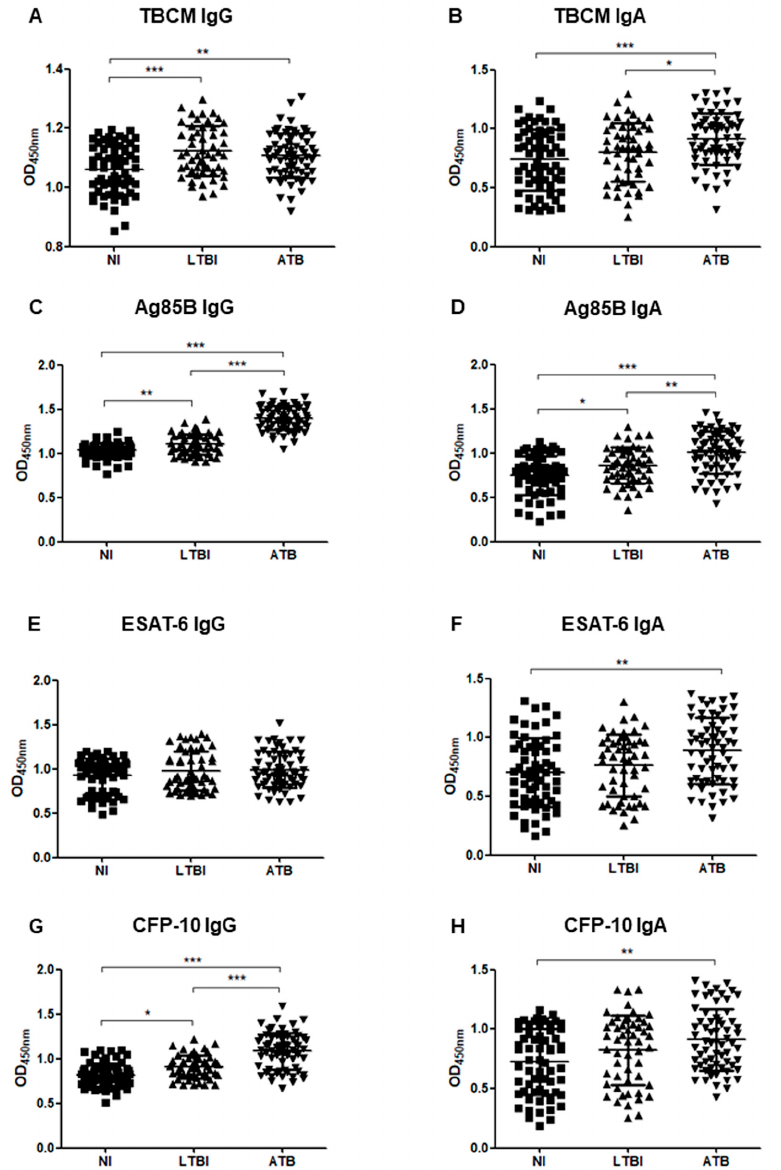
Figure 1. The optical density (OD) values of the anti-TBCM ( Mycobacterium tuberculosis chorismate mutase) immunoglobulin G (IgG) ( A ), anti-TBCM immunoglobulin A (IgA) ( B ), anti-antigen 85B (Ag85B) IgG ( C ), anti-Ag85B IgA ( D ), anti-ESAT-6 (early secreted antigen-6) IgG ( E ), anti-ESAT-6 IgA ( F ), anti-CFP-10 (culture filtrate protein-10) IgG ( G ), and anti-CFP-10 IgA ( H ) serodiagnosis assays for the comparison of 65 active tuberculosis (ATB), 53 latent tuberculosis infection (LTBI), and 62 non-infected individuals (NI). Each dot represents the values obtained from individual subjects, and horizontal bars indicate the average values. Groups were compared by one-way analysis of variance (ANOVA) with Bonferroni’s multiple comparisons. * p < 0.05; ** p < 0.01; *** p < 0.001.